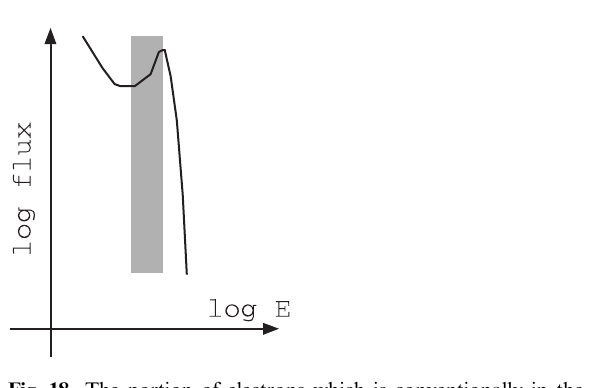
Fig. 18. The portion of electrons which is conventionally in the U- shaped potential drop model explained as backscattered and degraded primaries, can in the ‘‘boosted’’ O-shaped potential barrier model be produced by the wave-particle